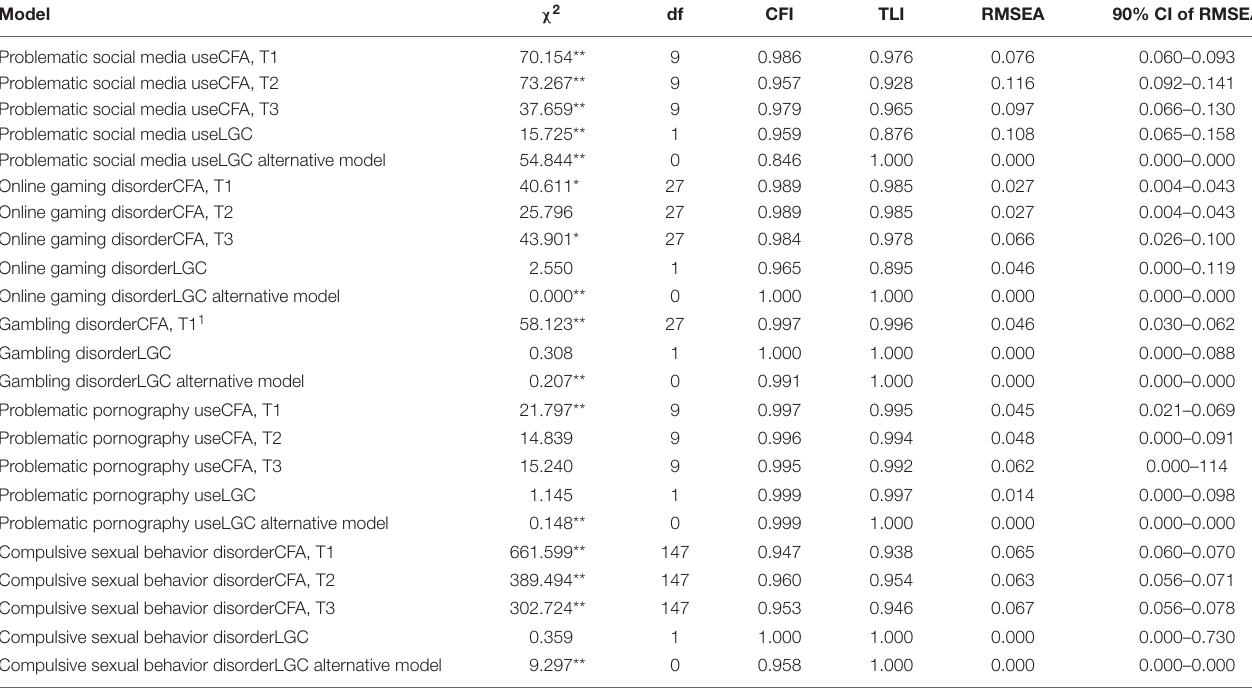
TABLE 3 | Goodness-of-fit statistics for the estimated